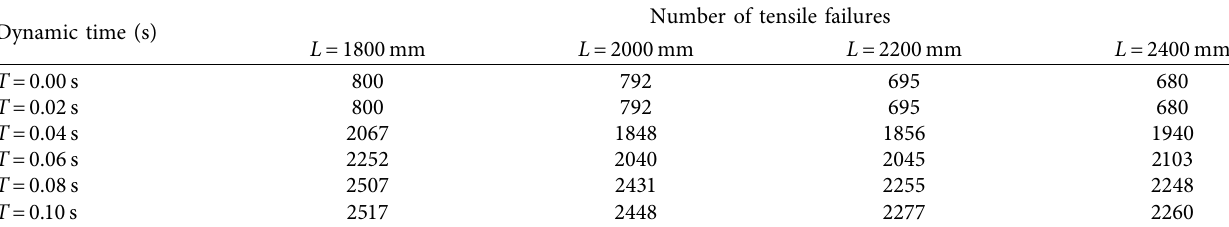
Table 5: Number of tensile failures with different bolt